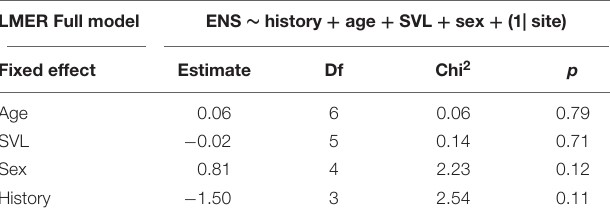
TABLE 2 | Summary of lmer model simplification